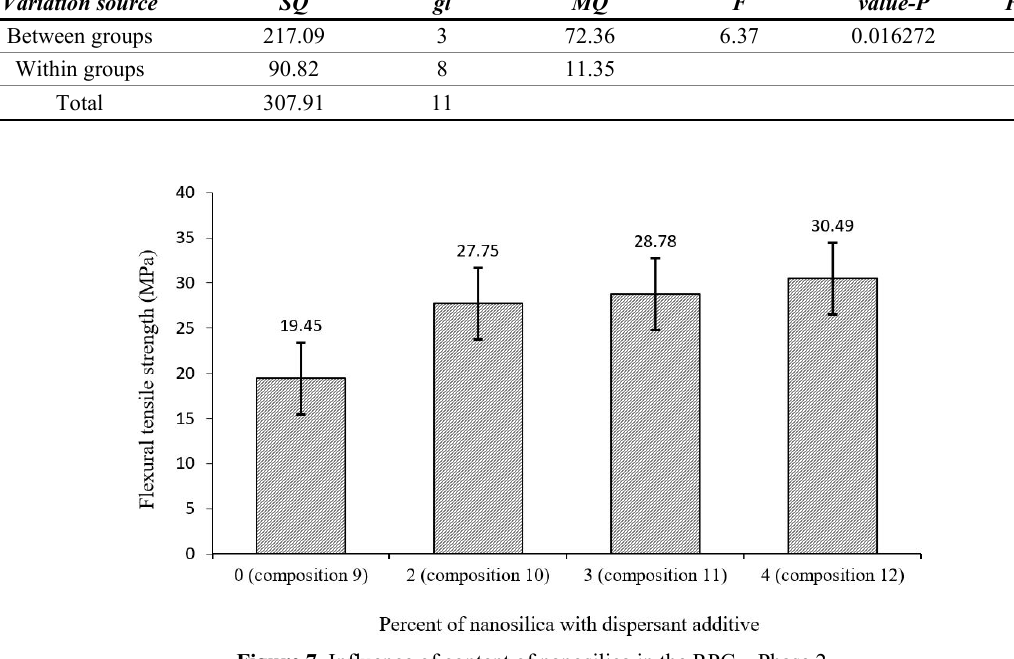
Figure 7. Influence of content of nanosilica in the RPC – Phase 2